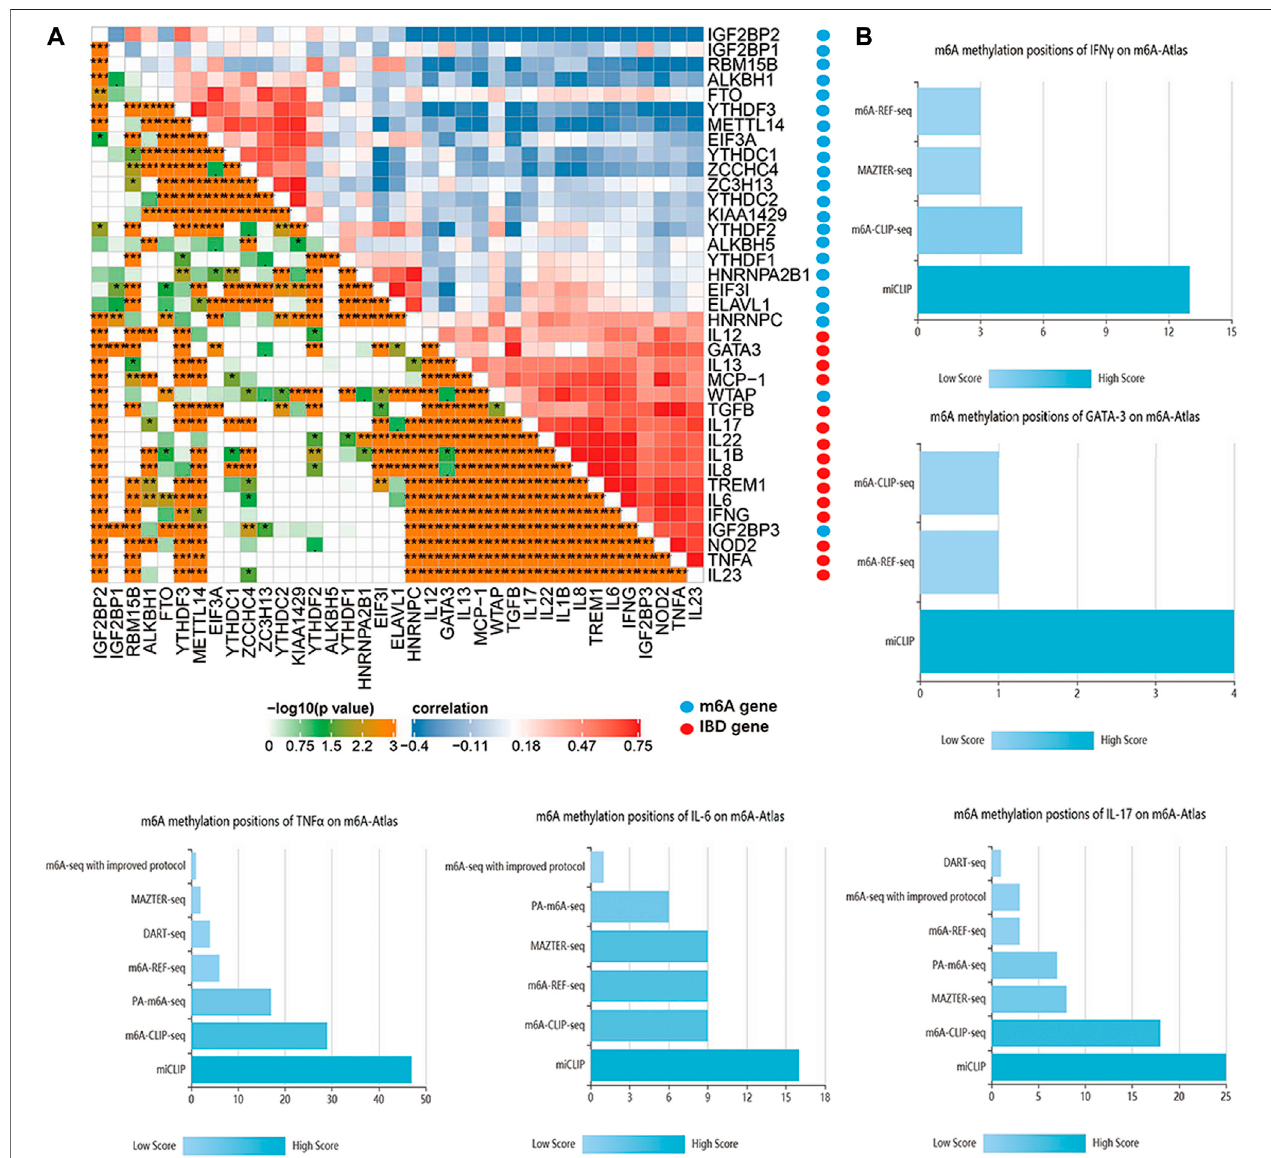
FIGURE 5 | The interaction of m6A regulators and IBD core cytokines. (A) is the correlation map of m6A regulators and IBD core cytokines. (B) is the m6A methylation positions of IBD core cytokines based on different m6A detecting technology.